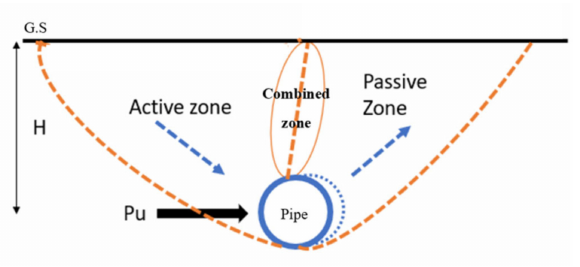
Figure 1. Lateral ground movement on buried pipe (adopted from O’Rourke and Liu